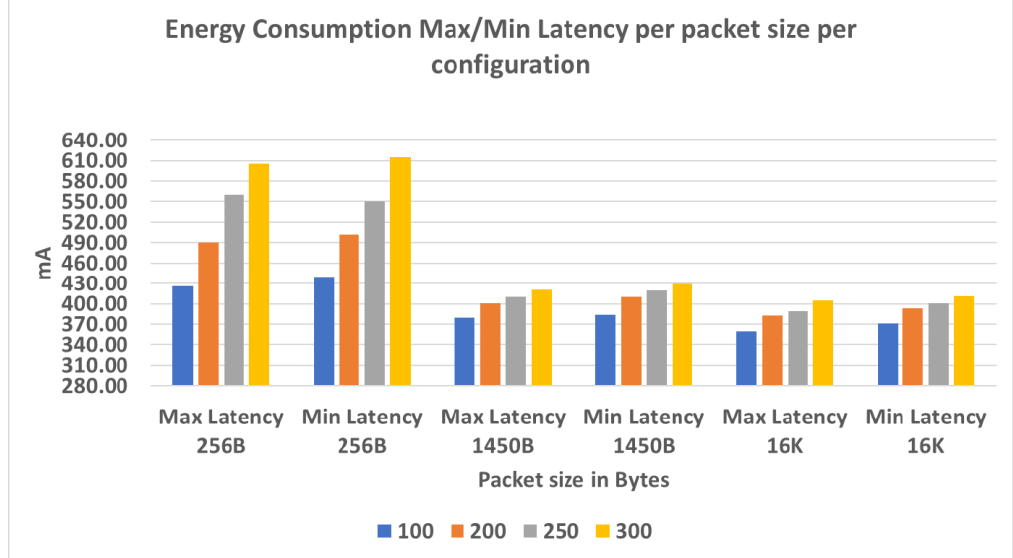
Figure 4. Energy consumption results for various packet sizes for the minimum and maximum latency eMBB slices.